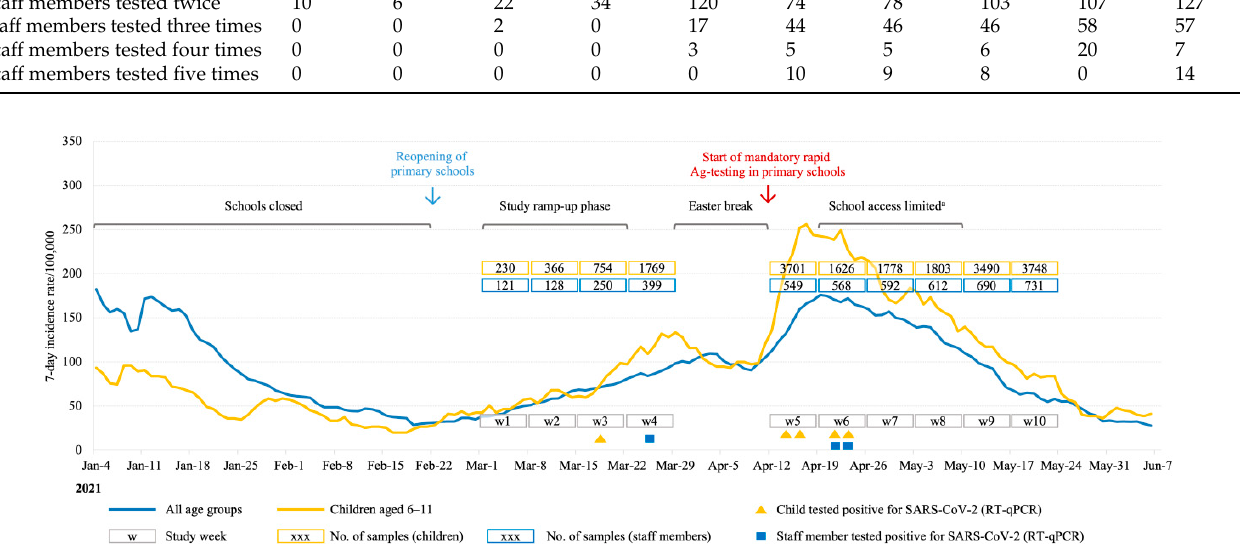
Figure 1. Pandemic activity and timeline of the Münchner Virenwächter 3.0 surveillance study